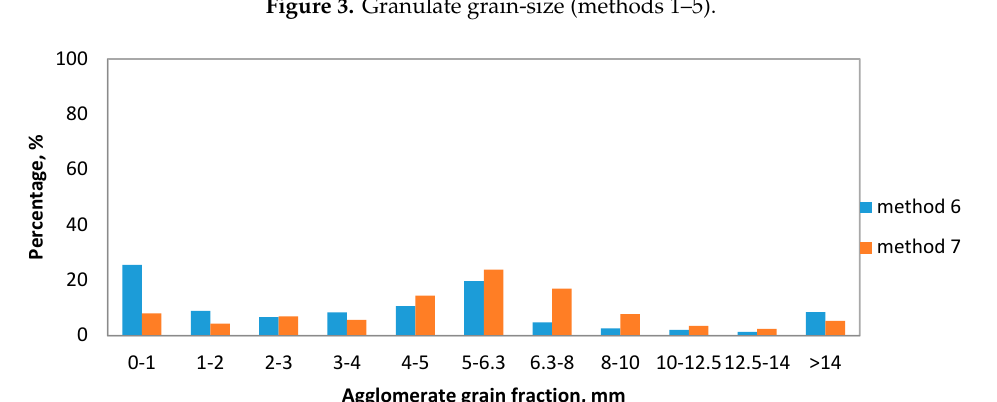
Figure 3. Granulate grain-size (methods 1–5).